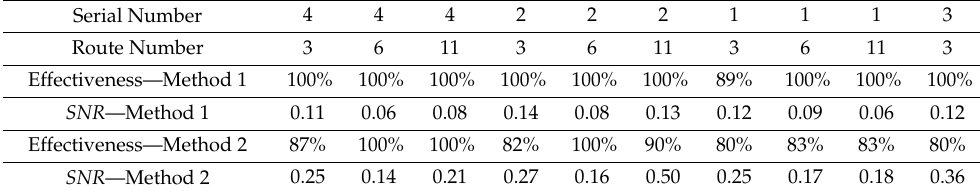
Table 5. Effectiveness of the detection of candidate objects after the introduction of conditions.